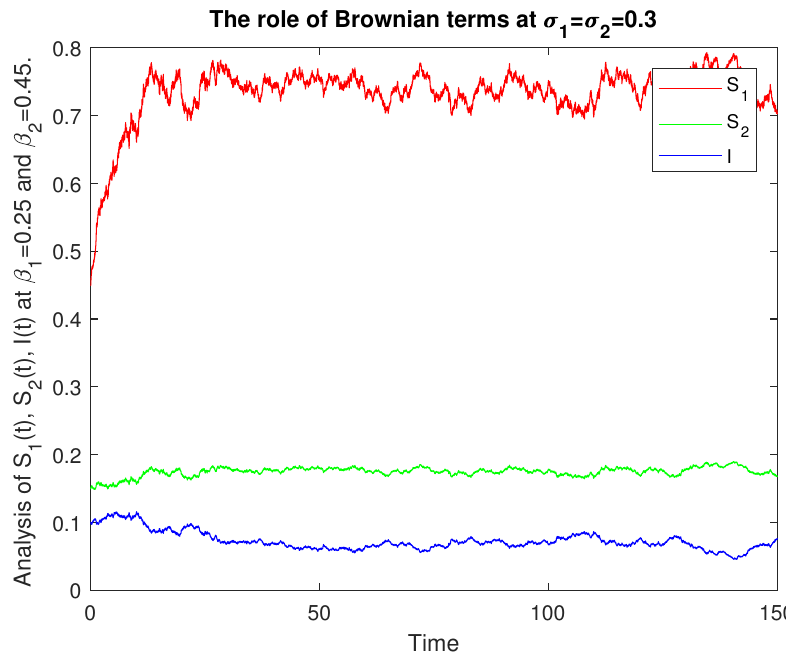
Figure 9. Comparative analysis of S 1 ( t ) , S 2 ( t ) , I ( t ) for β 1 = 0.25, β 2 =